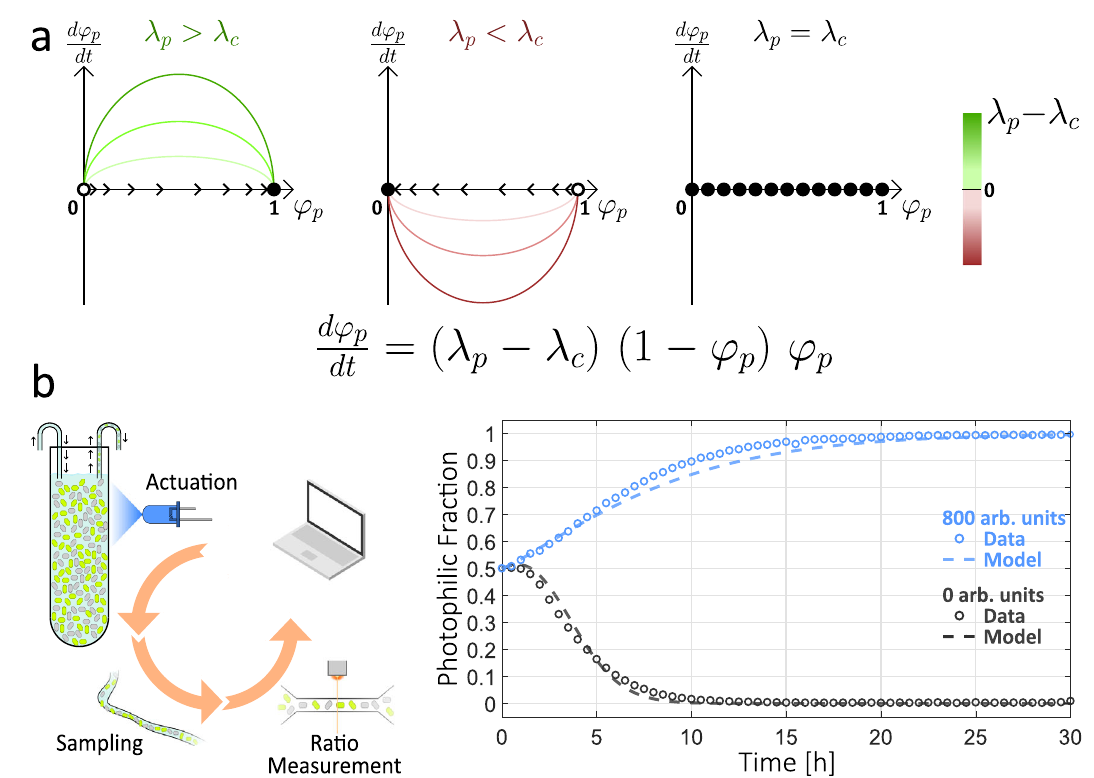
Fig. 5 | Open-loop dynamics of the photophilic-consitutive co-culture. a The compositionofthephotophilic-constitutiveco-culturecanbecharacterizedbythe photophilic strain fraction φ p , whose dynamics obey the depicted ODE. Phase portraits illustrate three qualitatively distinct scenarios. Full and empty circles denote stable and unstable fi xed points, respectively, and trajectories evolve in timefollowing the fl ow denotedbythearrows.Inallcases, thesignand magnitude of the growth rate difference, λ p − λ c , determine the fate of φ p and the speed of convergence to equilibrium. If λ p > λ c , the photophilic strain inevitably dominates: φ p =1 (Left). If λ p < λ c , the constitutive strain dominates: φ p =0 (Center). If the